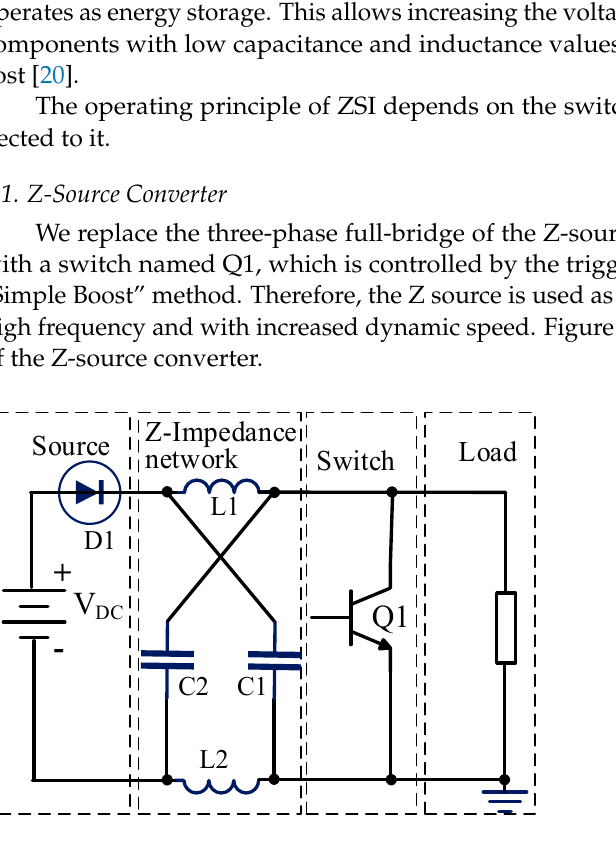
Figure 4. Electrical diagram of a three-phase full-bridge Z-source inverter.